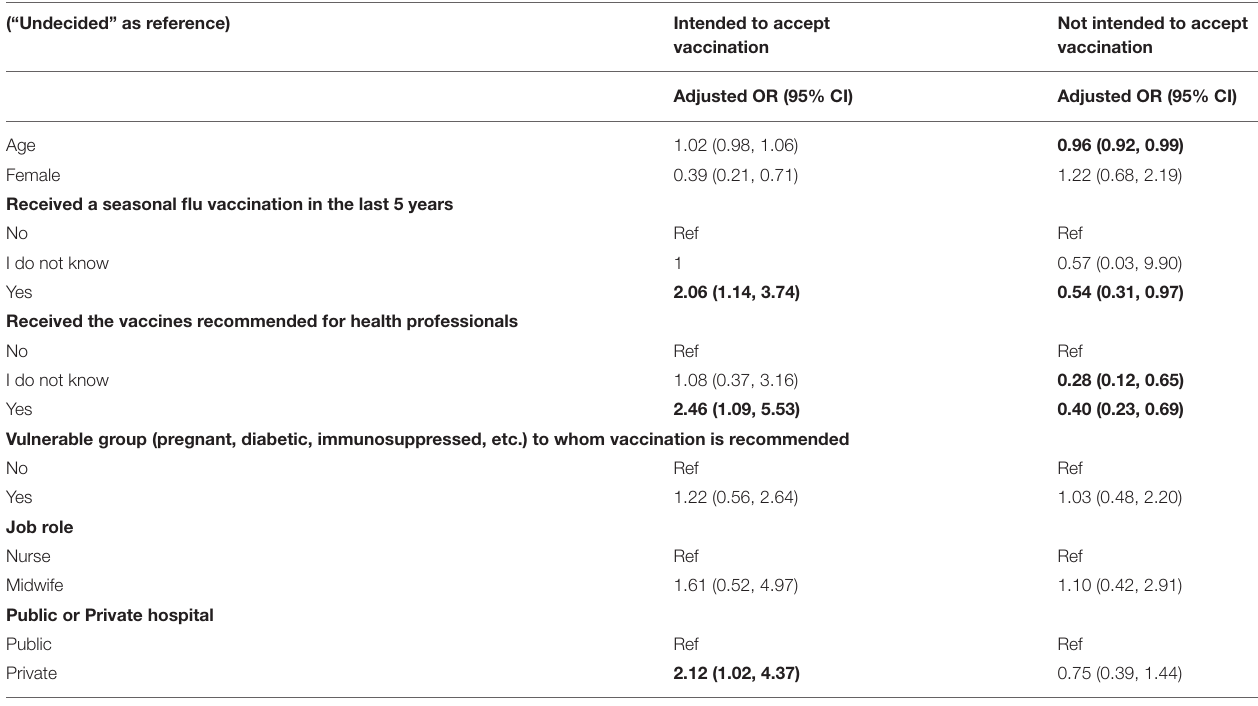
TABLE 3 | Multinomial logistic regression models for the association between intentions of COVID-19 vaccination acceptance and possible predictors adjusting for age and gender. (“Undecided” as